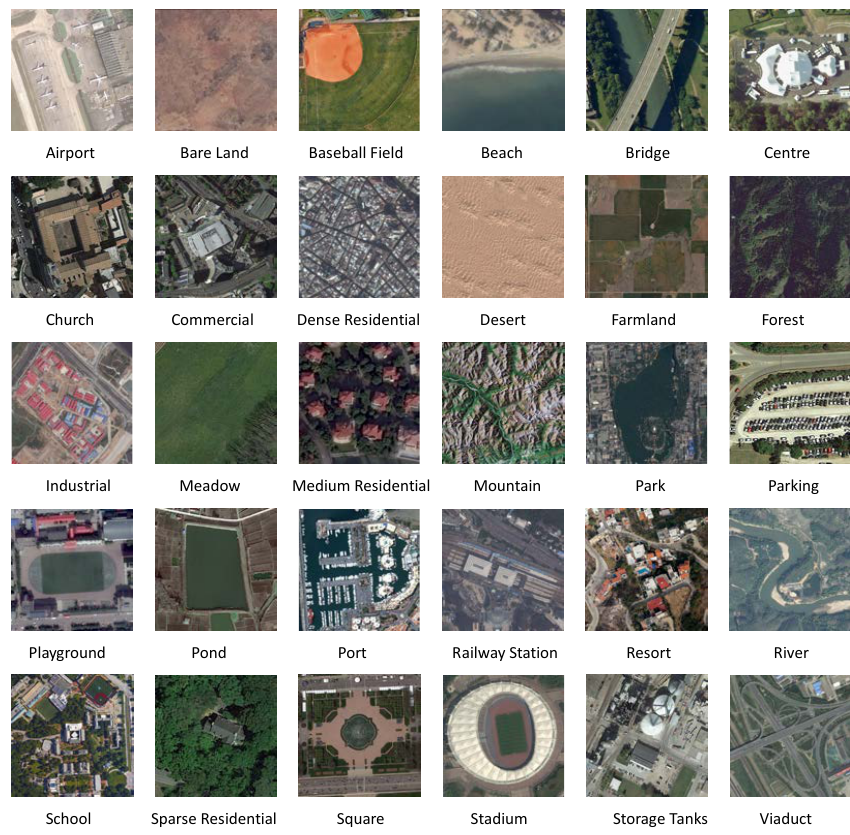
Figure 6. Example images of the AID